Question: Draft a figure caption describing what is shown.
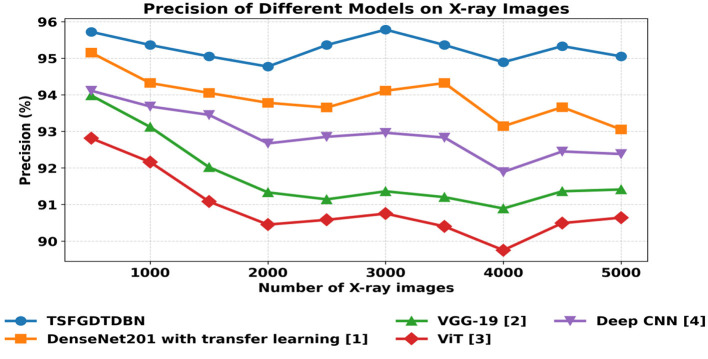
Answer: Performance analysis of precision using Multi-Class Knee Osteoporosis X-ray Dataset.